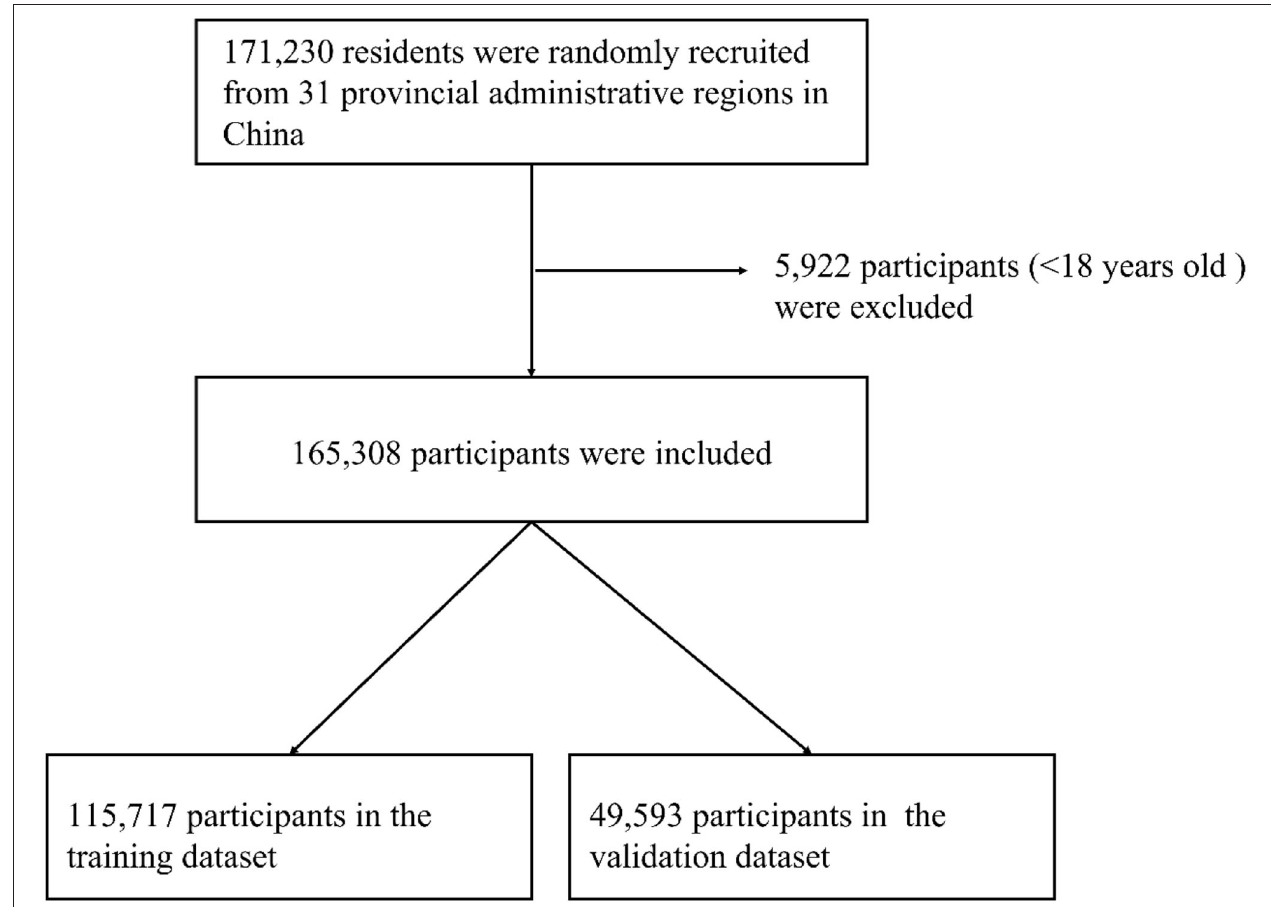
FIGURE 1 | The flow chart for the sampling in this study: 31 provincial administrative regions,